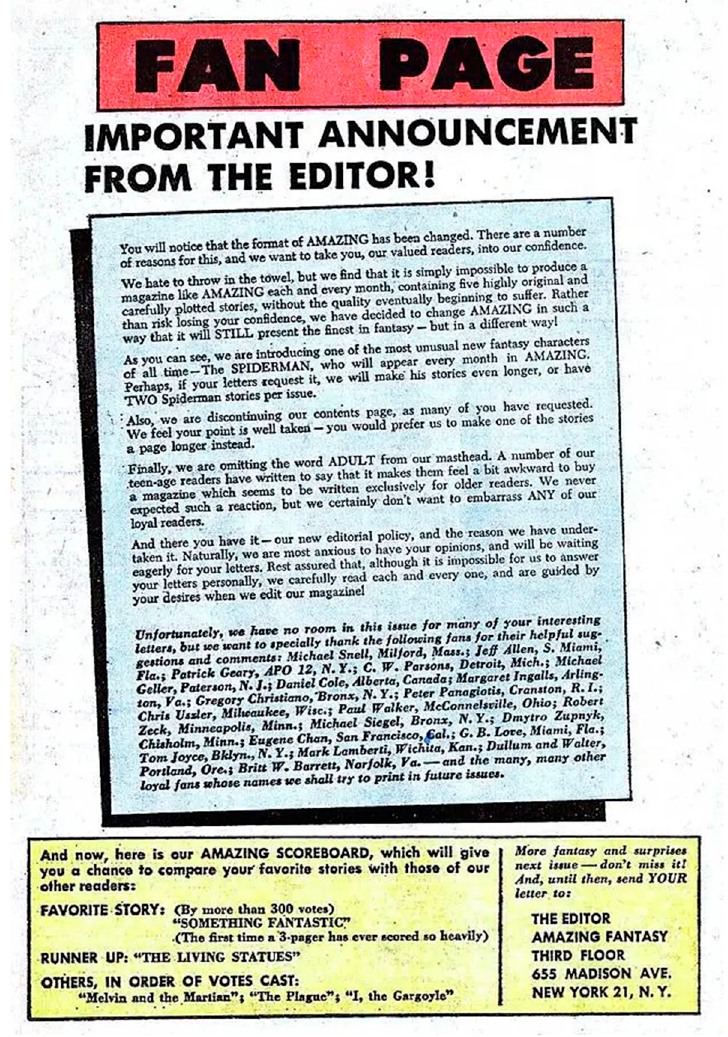
Figure 3. “Fan Page,” Amazing Fantasy #15 (August